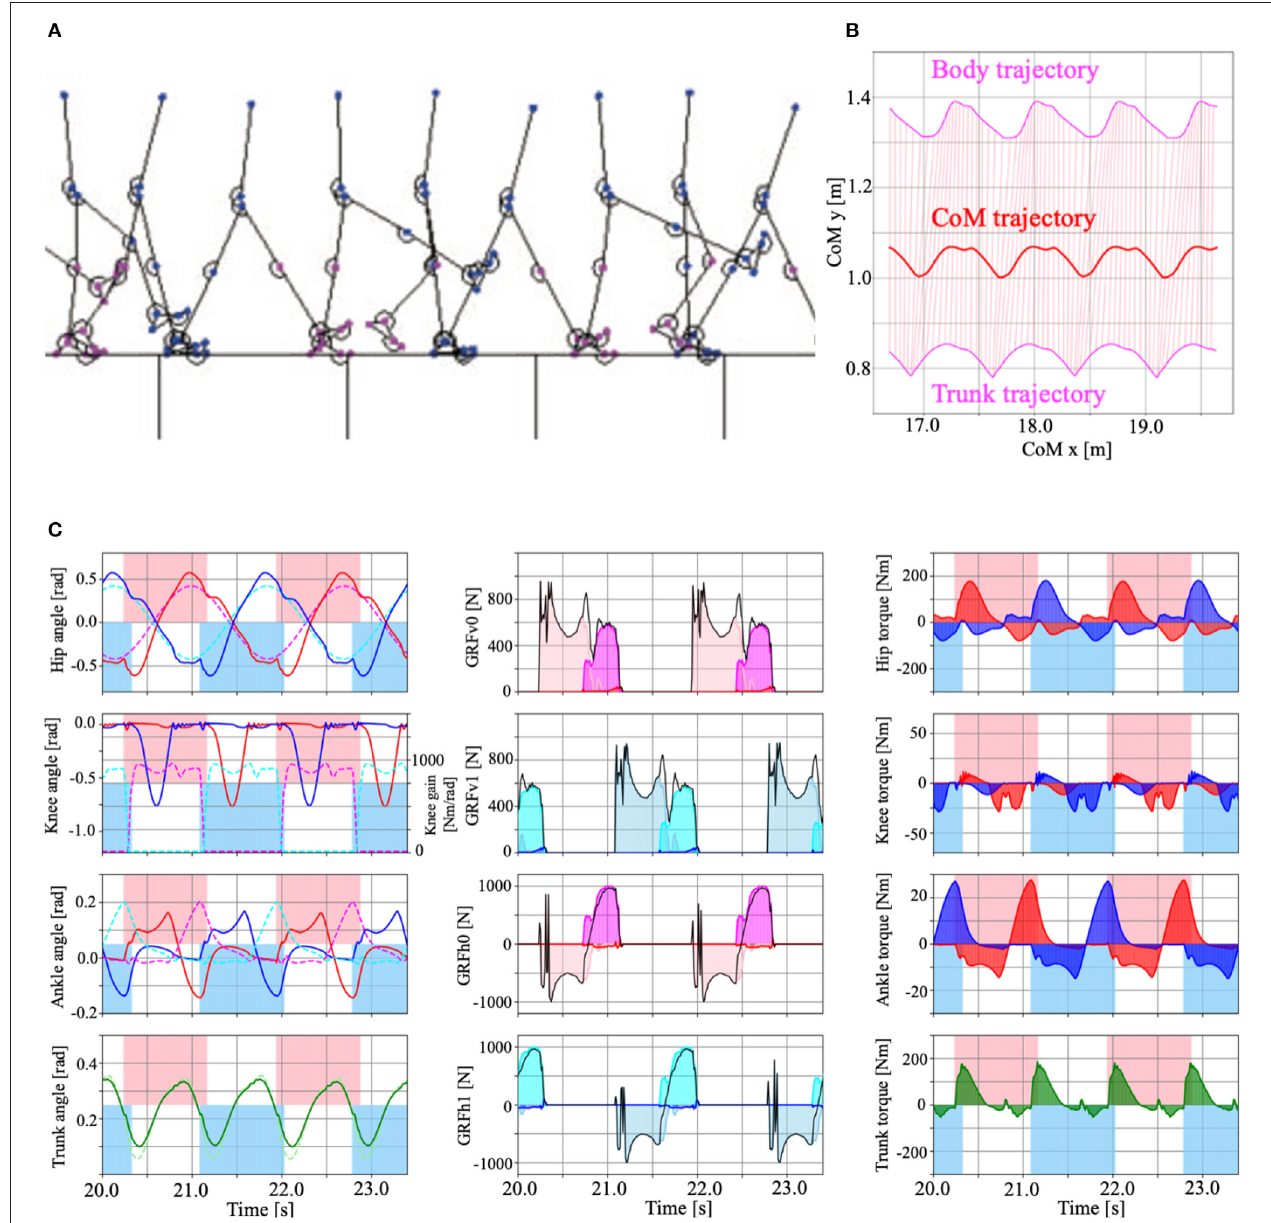
FIGURE 7 | (A) Example of the model walking in steady-state (Model 3 with PC, Supplementary Movie 1 ). (B) Body, trunk (magenta), and CoM (Centre of Mass, red) trajectories during the steady walking. Pink lines represent the torso link that connects the body and trunk mass. (C) Time series data of the steady walking in Model 3 with PC. Left panels show the hip, knee, ankle, and trunk angle from top to bottom. The red and blue lines show the left and right legs, respectively. The dotted magenta (left leg), cyan (right leg), and light green (trunk) lines represent the target angle of the hip, ankle and trunk, and the knee gain that determined by Tegotae-based control. The centre panels show vertical (top, second) and horizontal (third, bottom) ground reaction forces (GRFs). The pink, magenta, and red coloured regions represent the vertical forces applied to the heel, metatarsals, and toe masses on the left leg. The sky blue, cyan, and blue coloured regions represent the horizontal forces applied to the heel, metatarsals, and toe masses on the right leg. The right panels represent the torque applied to the hip, knee, ankle, and trunk joints by the PD control. The red, blue, and green colour regions represent the left, right legs, and trunk, respectively. For the left and right panels, the pink and sky blue coloured regions represent the stance phase of the left and right legs, determined by the vertical GRFs ( N V i > 0), respectively.